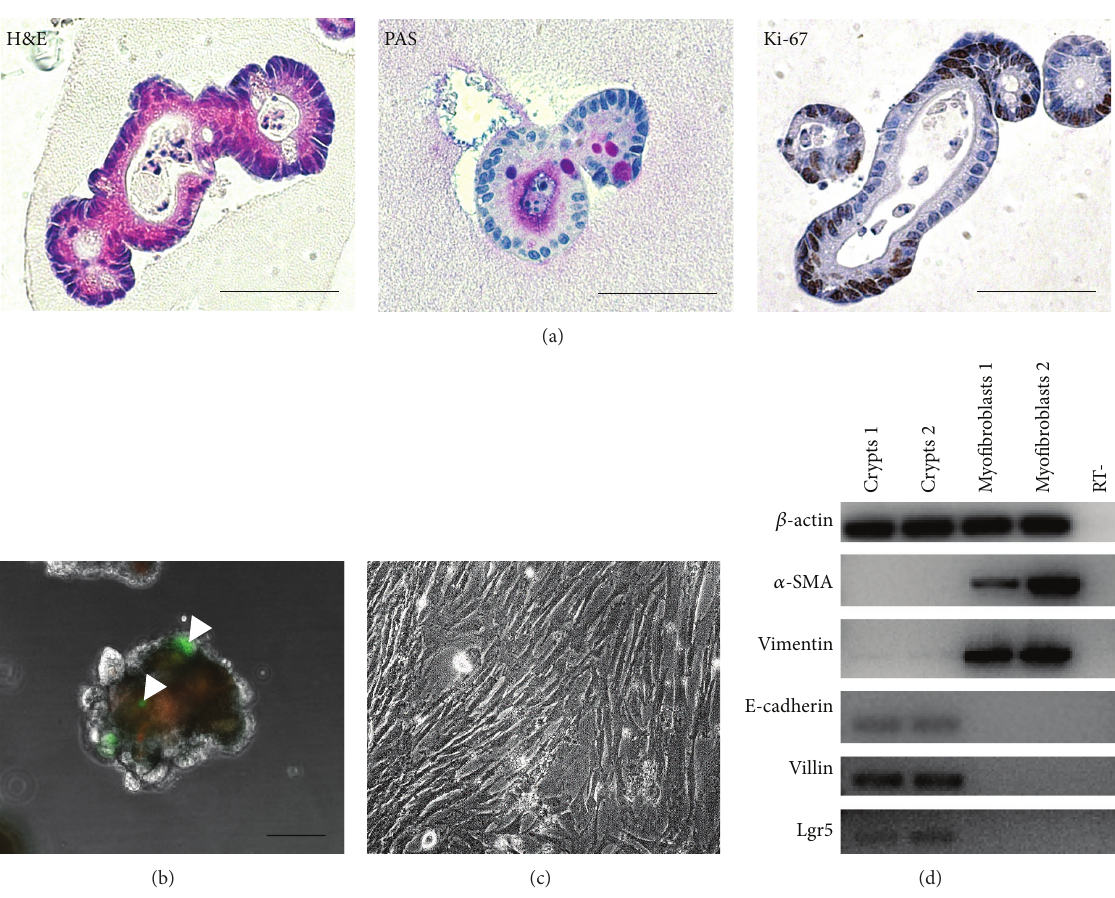
Figure 2: Characterization of small intestinal organoids and small intestinal myofibroblasts used to reconstruct intestinal stem cell niche ex vivo . (a) H&E staining, PAS staining, and Ki-67 staining of small intestine organoids. Scale bar, 50 𝜇 m. (b) Lgr5-GFP-positive epithelial cells in cultured conditions (marked with arrowheads). Scale bar, 100 𝜇 m. (c) Morphology of small intestine myofibroblasts, phase contrast microscopy. (d) Confirmation of the purity of small intestine organoids and small intestine myofibroblasts by Reverse-Transcription PCR. RT- (reaction without the addition of reverse transcriptase) served as the negative